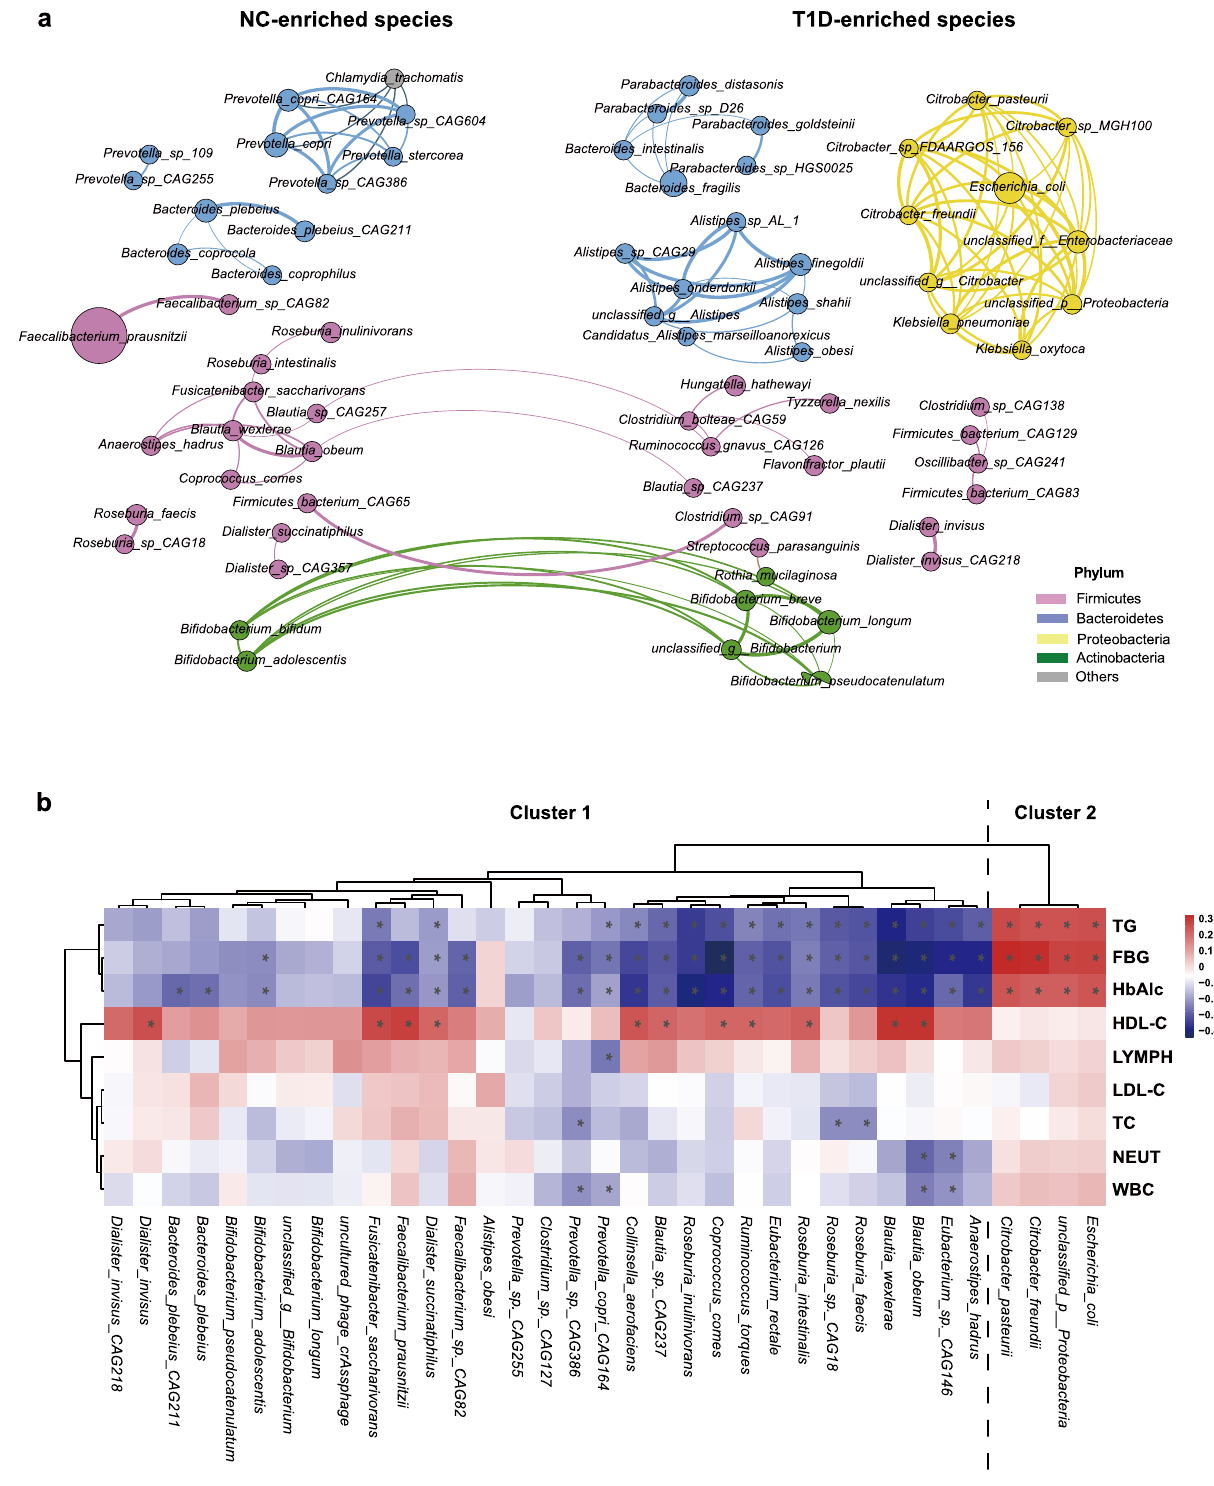
Fig. 2 | The T1D-associated microbial species revealed by metagenomic analy- sis. a Co-abundance network constructed from the microbial markers of T1D by a random forest model using the top 100 most abundant species. The node size indicates the relative abundance of each bacteria species and color indicates the phylum. The thickness of the line between nodes represents the Spearman coef fi - cient. A total of 72 species were displayed with Spearman ’ s correlation values over